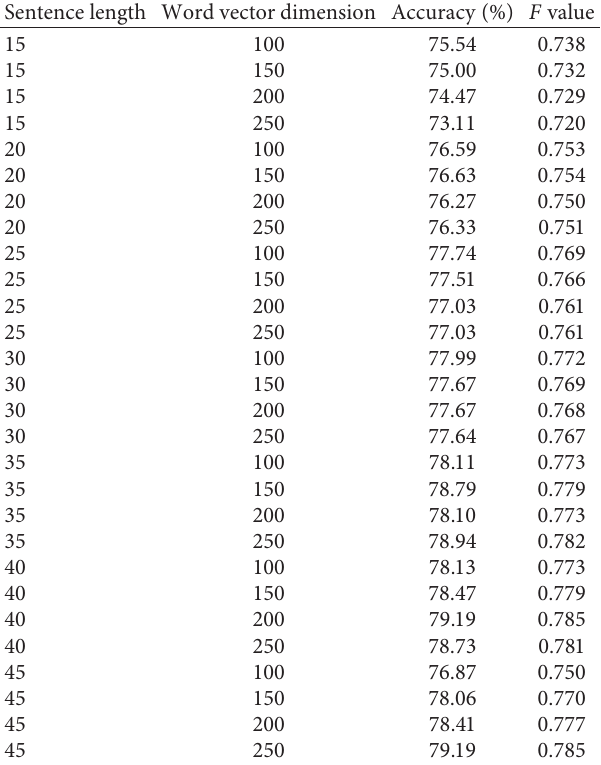
Table 5: Support vector machine classifier classification results.